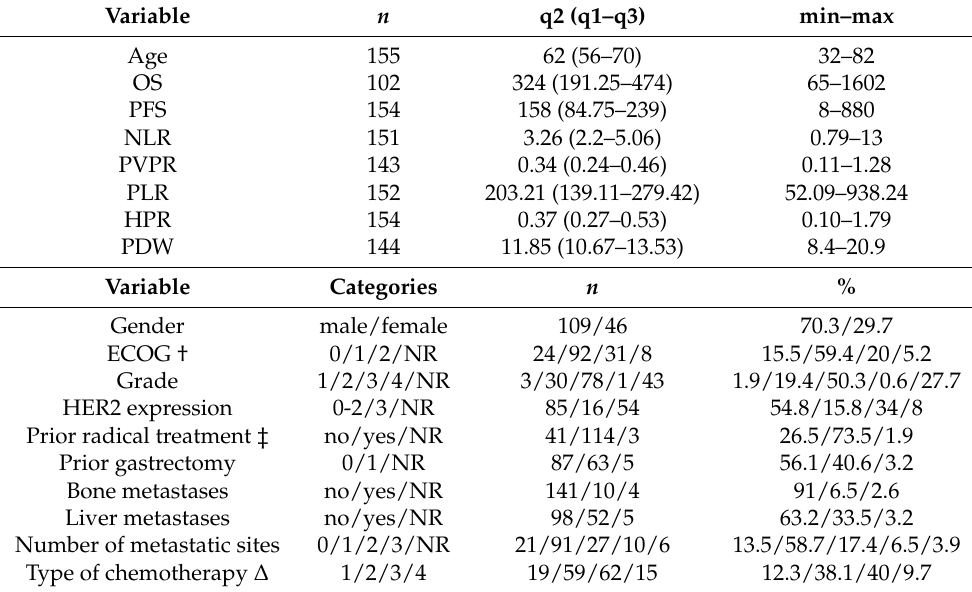
Table 1. Characteristics of categorical and continuous